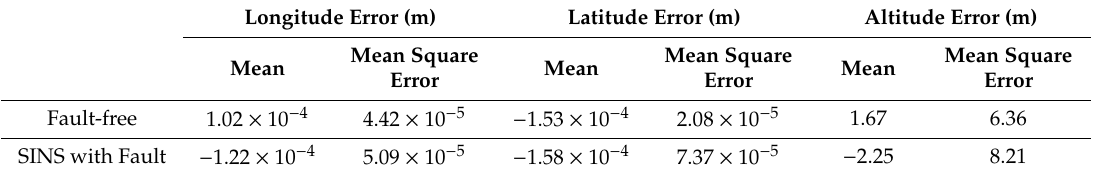
Table 4. The Comparative Data Analysis of Position Errors of the Inertial Sensor with and without Faults.